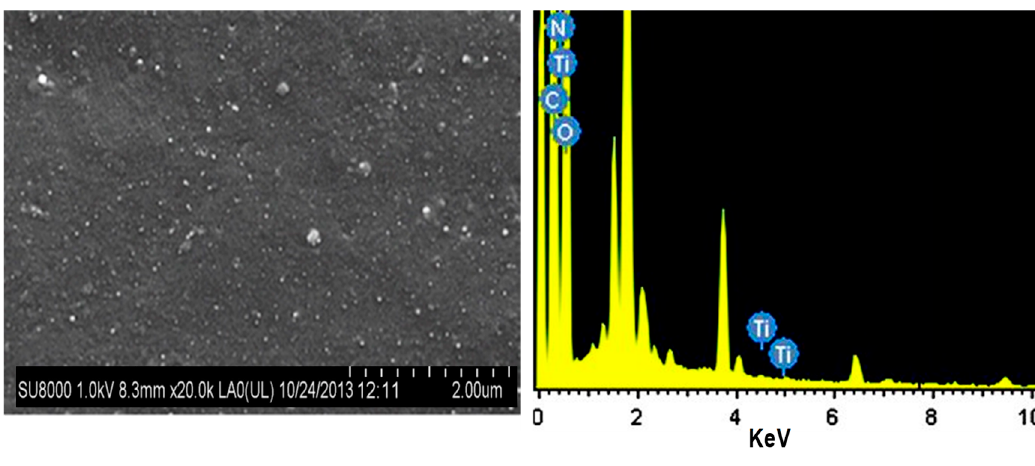
Figure 2. SEM micrograph (left) and EDX (right) of AELO/TiO 2 (7.5 wt %) nanocomposite. Reprinted from [46], copyright 2015, with permission from the Royal Society of Chemistry.